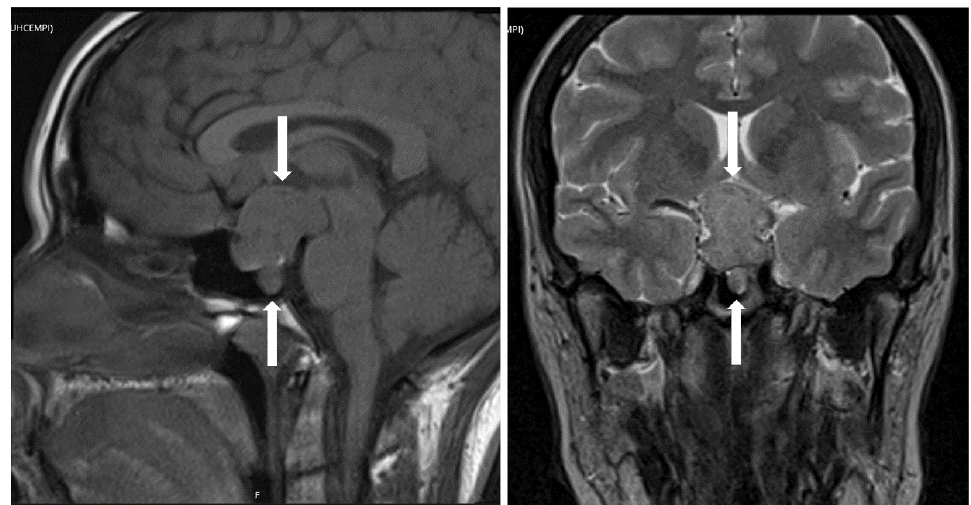
Figure 4. Magnetic resonance imaging of sparsely granulated somatotroph tumor. The pituitary tumor has expanded upwards to compress the optic chiasm and infiltrated downwards through the floor of the sella turcica into the sphenoid sinus (straight arrows, right and left ). On T2 weighted imaging this lesion is hyperintense.